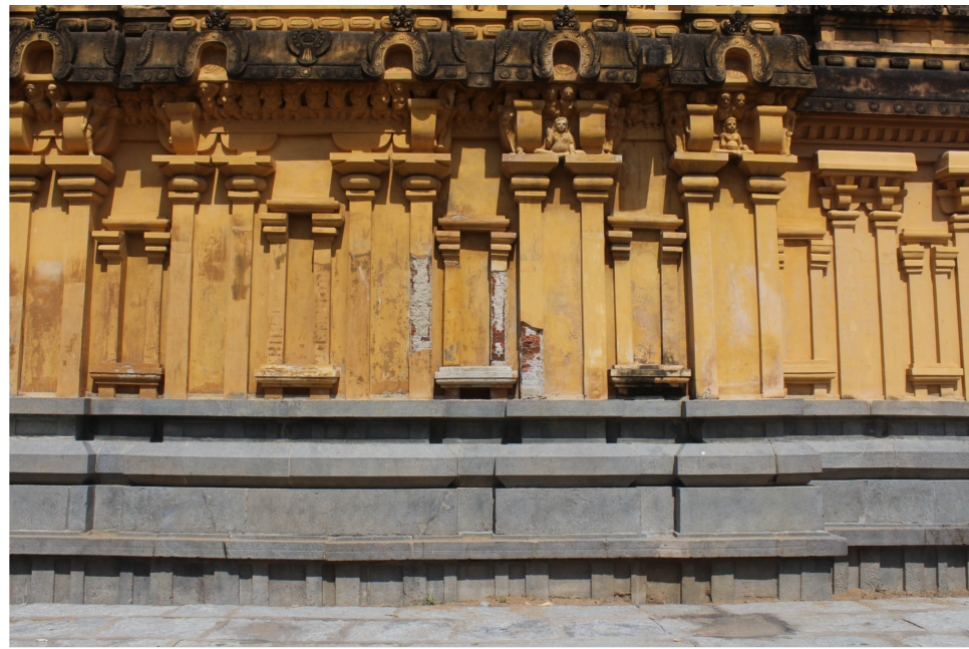
Figure 7. Kail ā san ā tha temple, Uttiramerur, Tamil Nadu, 9th century. Photograph by Emma Na- Figure 7. Kail¯asan¯atha temple, Uttiramerur, Tamil Nadu, 9th century. Photograph by Emma Natalya talya Stein.